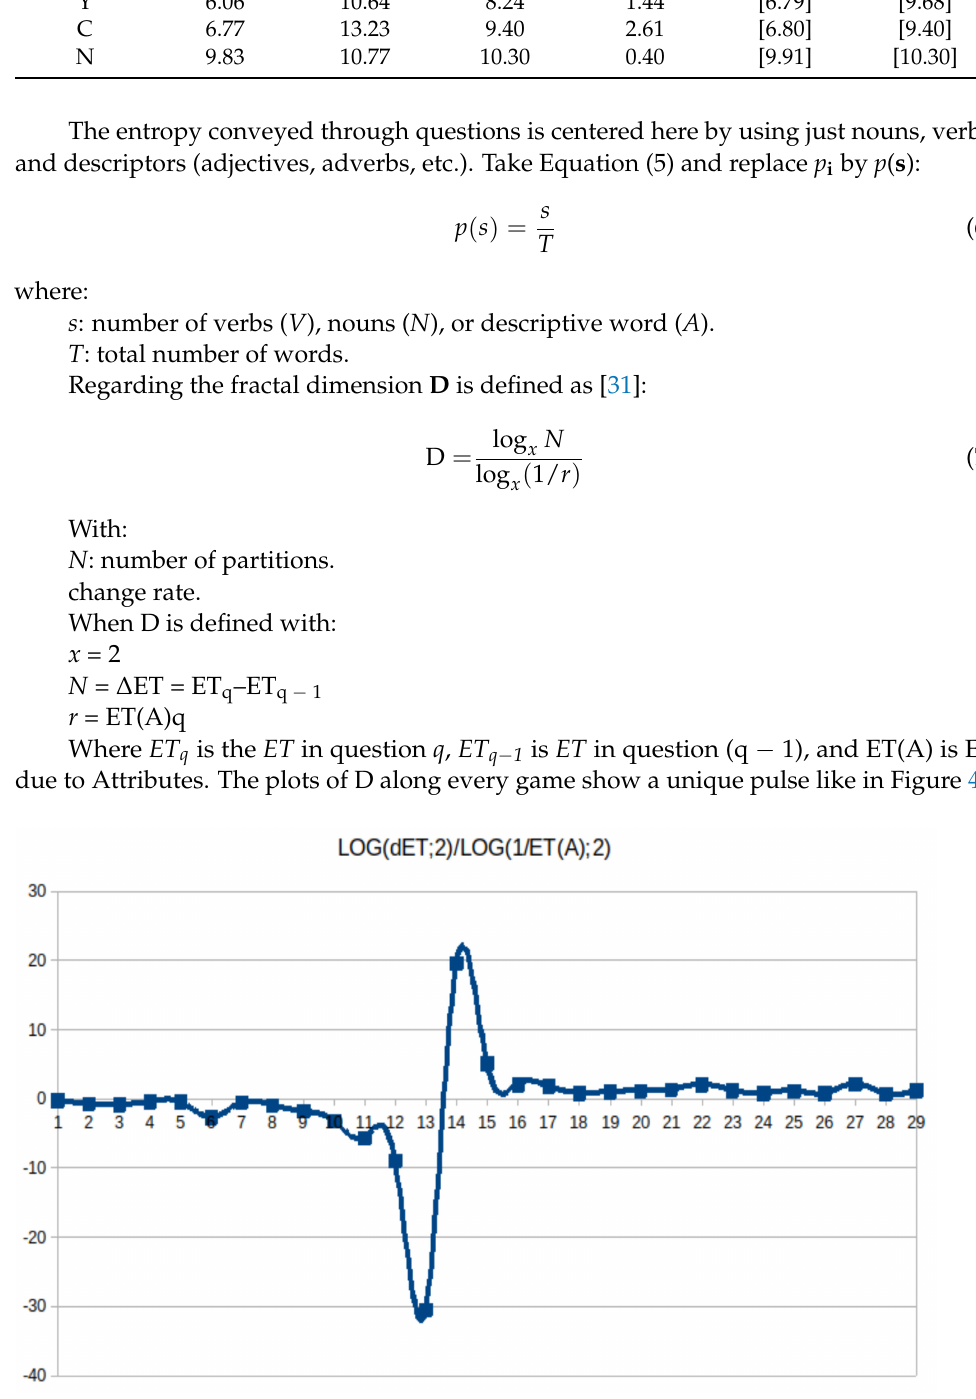
Figure 4. D for test